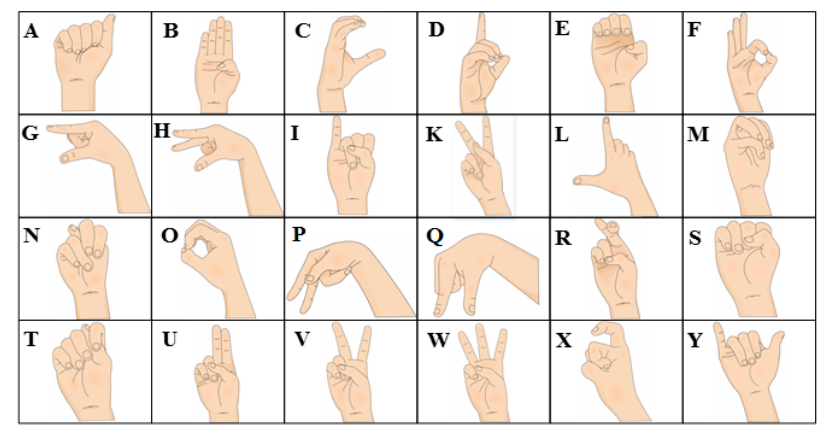
Figure 7. American Sign Language alphabet community used, including letters from A to Y excluding letter J.